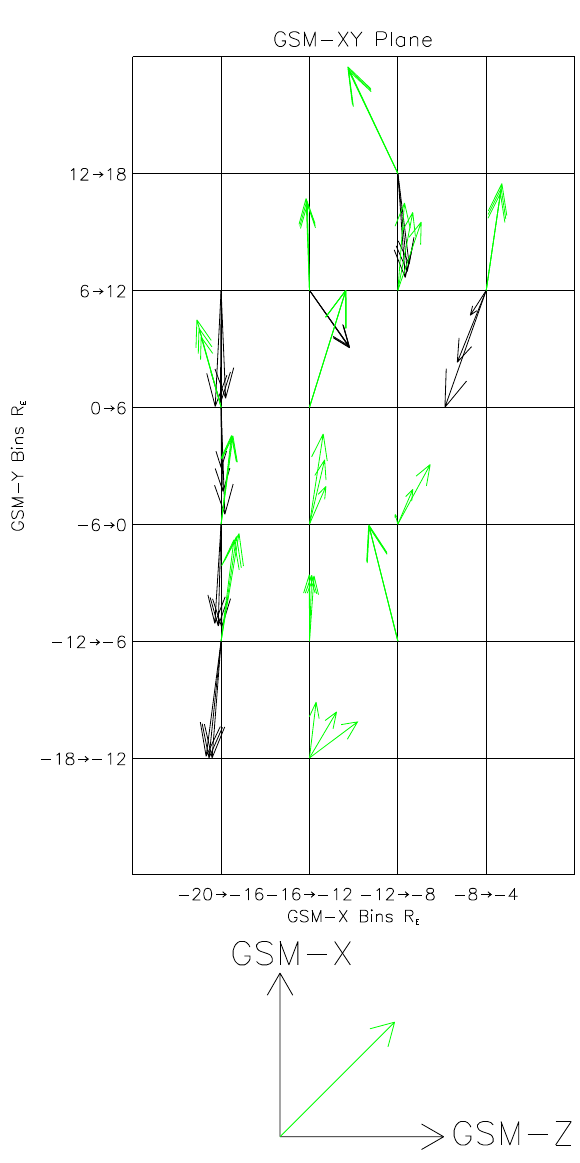
Fig. 14. The projection of the average unit normal of the boundary between the expanding plasma sheet and the lobe in the GSM–ZX direction is shown as a function of position in the GSM–YX plane for two GSM–Z bins. Plasma sheet to lobe crossings are marked in green and black vectors for the north and south lobes, respectively. Error bars, calculated from the extreme errors on the individual vec- tors, are plotted when more than one normal vector was used for the averaging. In the pre-midnight sector of the Northern Hemisphere the expansions, on average, have a negative GSM–X component that is reversed on the post-midnight sector. Bar a couple of ex- ceptions, the expansion vectors in the south lobe have a GSM–X component ranging from minimal to strongly